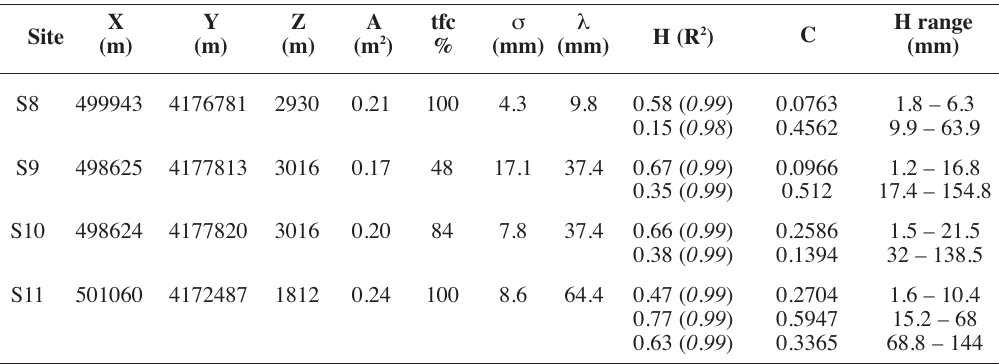
Table I. Roughness parameters of investigated sites.